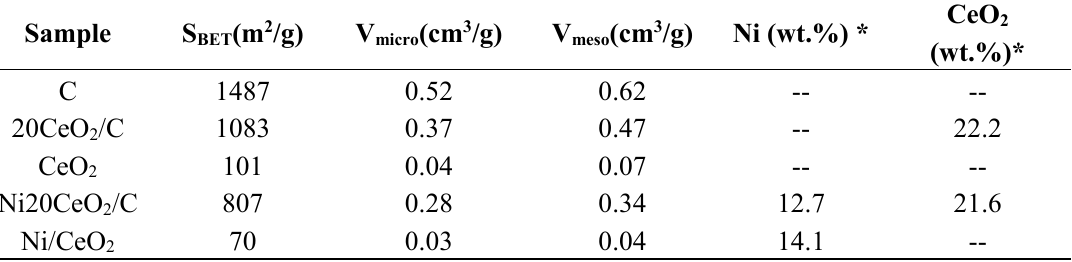
Table 1. Catalysts composition and textural properties of the prepared